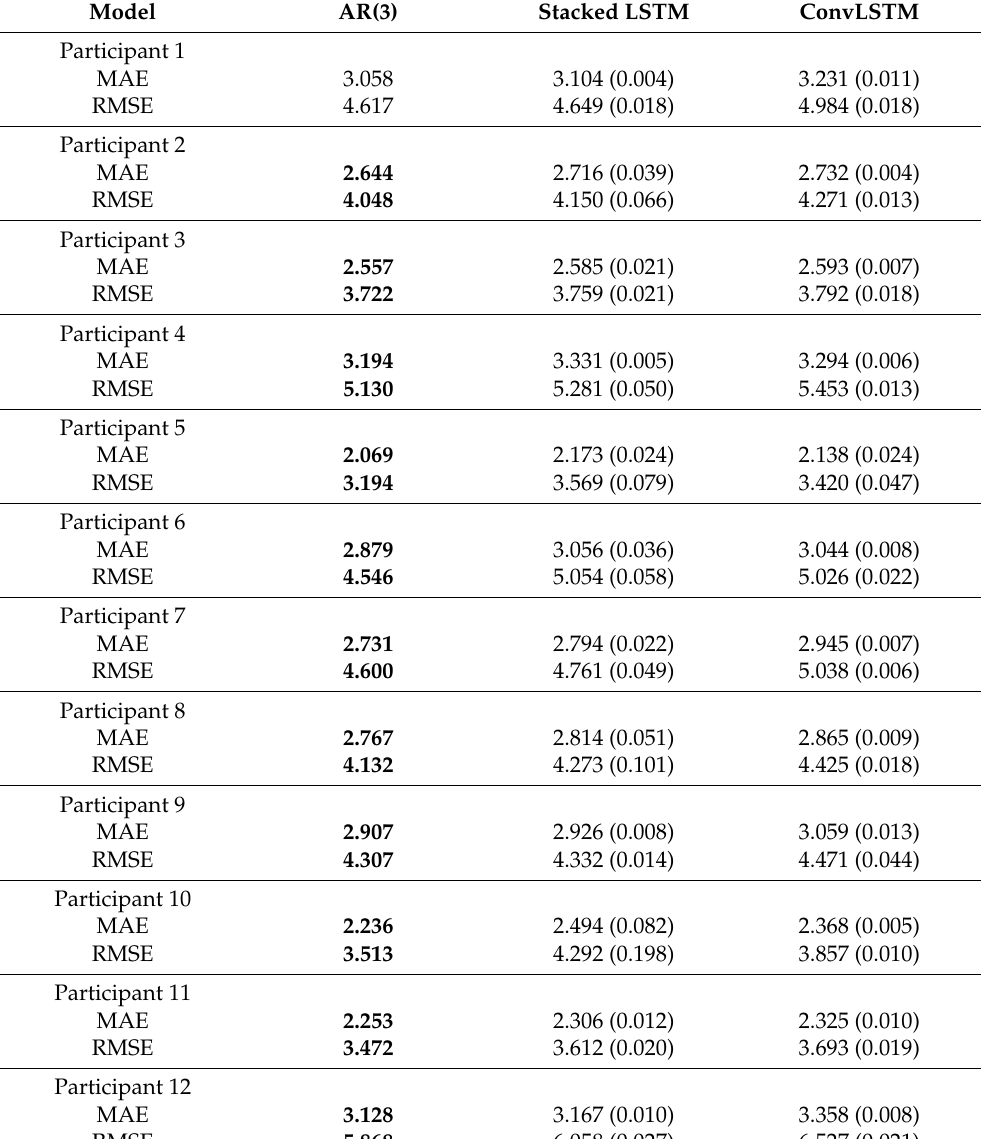
Table 2. Mean Absolute Error and Root Mean Square Error of the tested